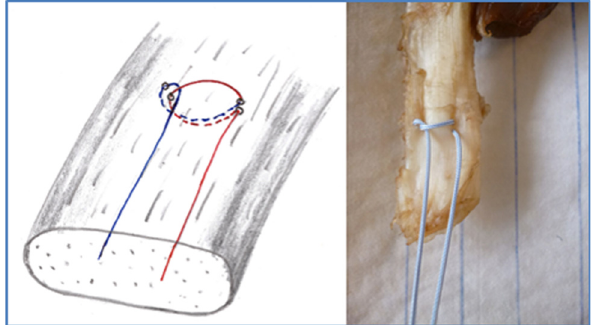
Figure 1: Single - loop knot stitch ( SLKS ) . Schematic illustration on the left. The photo on the right shows that only a smaller part of the tendon is grasped with the